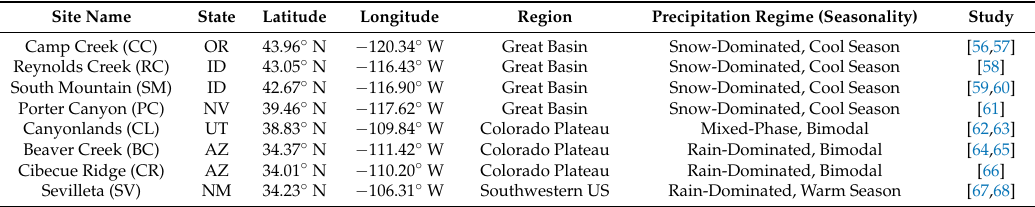
Figure 2. Maps of average mean annual precipitation ( a ), snow fraction (( b ), percent of annual precipitation as snow), and the monsoon index (( c ), fraction of the annual precipitation that occurs in July, August and September) across the pinyon ( Pinus spp.) and juniper ( Juniperus spp.) domain in the western US. Study sites from Table 1 are depicted with site abbreviations. Table 1. Locations of pinyon ( Pinus spp.) and juniper ( Juniperus spp.) woodland study sites plotted in Figures 1 and 2 and associated precipitation regime and respective references. See Figure 1 for region locations in USA. Here, we characterize the Arizona and New Mexico Plateaus Region (i.e., Beaver Creek and Cibecue Ridge sites) as representative of the southern portion of the Colorado Plateau, with a bimodal and rain-dominated annual precipitation regime.